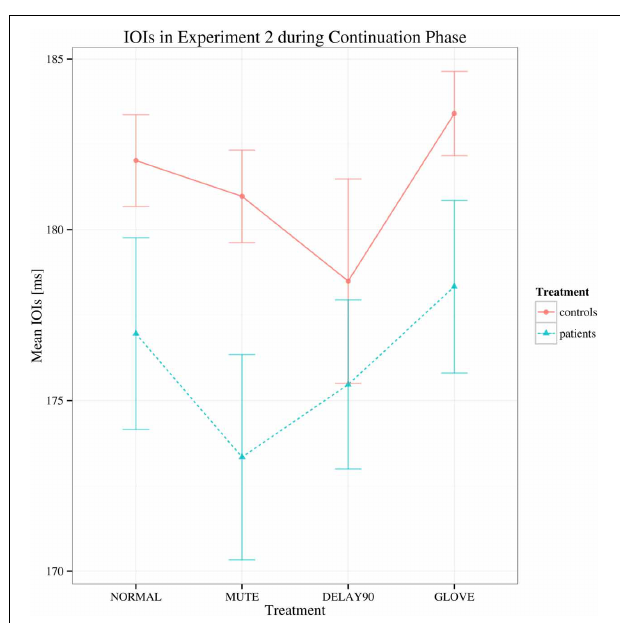
FIGURE 4 | Interaction plot of mean IOIs for Experiment 2 during continuation phase. Details as in Figure 1 . Error bars denote 95% confidence intervals.